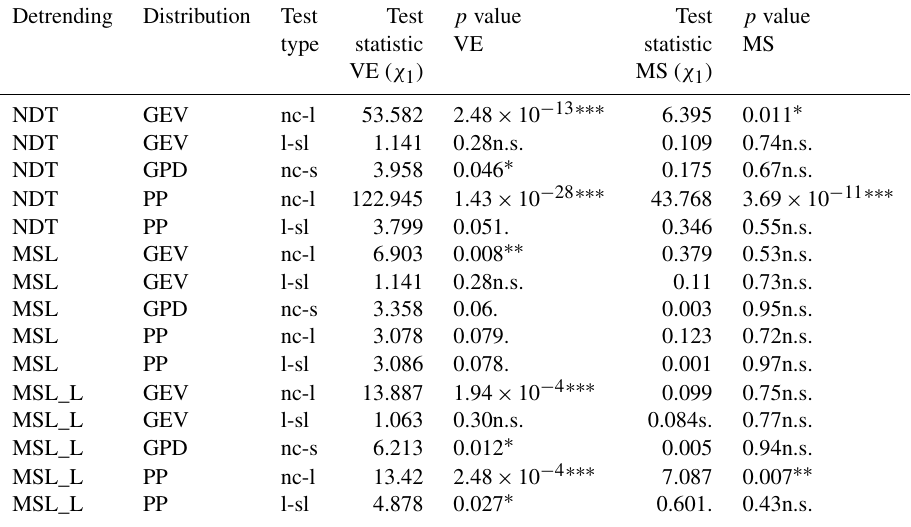
Table 2. Likelihood ratio test results. The column test type describes which model configurations were compared; nc-l: no covariates com- pared with covariates on location; l-sl: covariates on location compared with covariates on both location and scale; nc-s: no covariates compared with covariates on scale. VE denotes Venice; MS denotes Marseille.